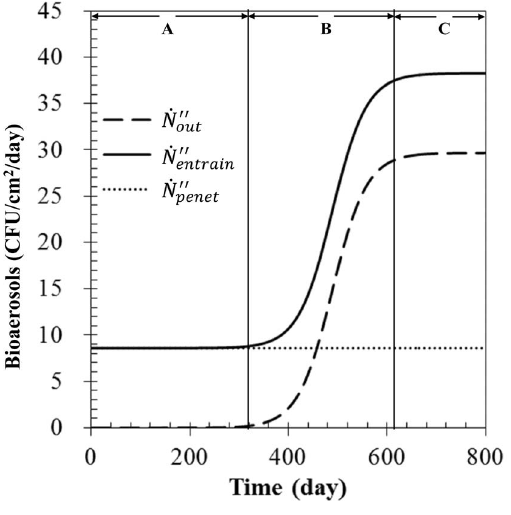
N ˝ N ˝ N entrain , N penet , and N out of Filter